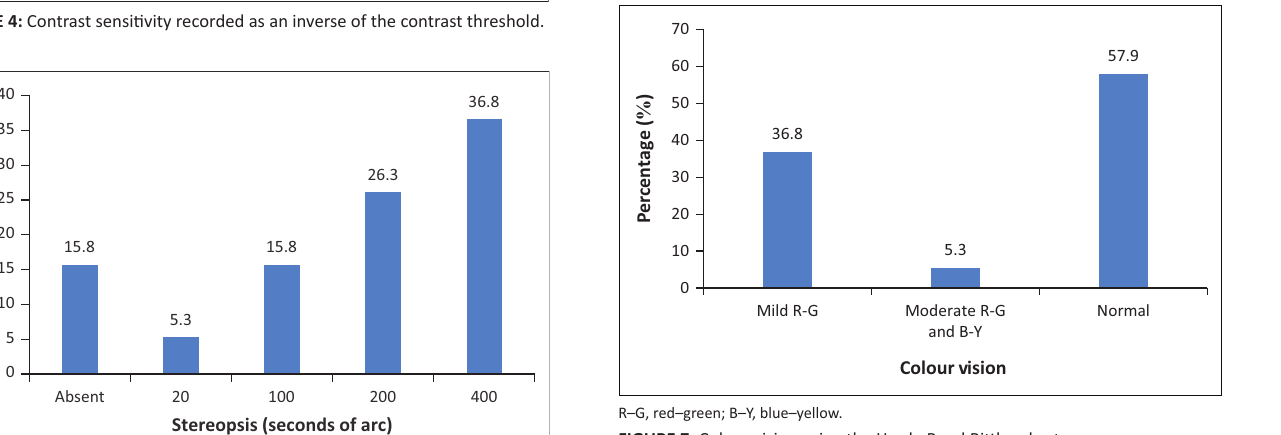
FIGURE 7: Colour vision using the Hardy-Rand Rittler